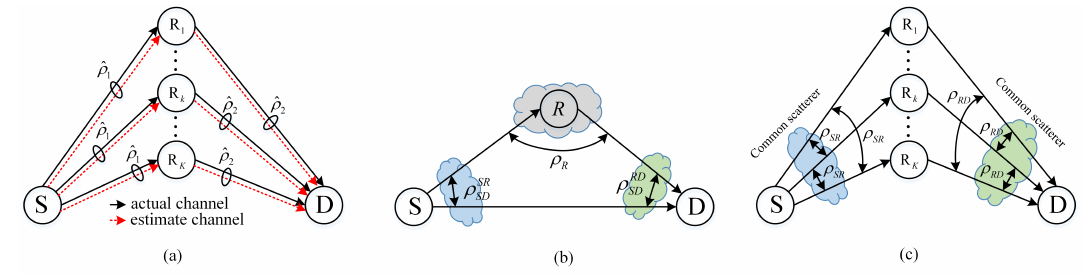
Figure 2. Cooperative systems in correlated environments have been investigated in ( a ) [17–19]; ( b ) [20]; and ( c )